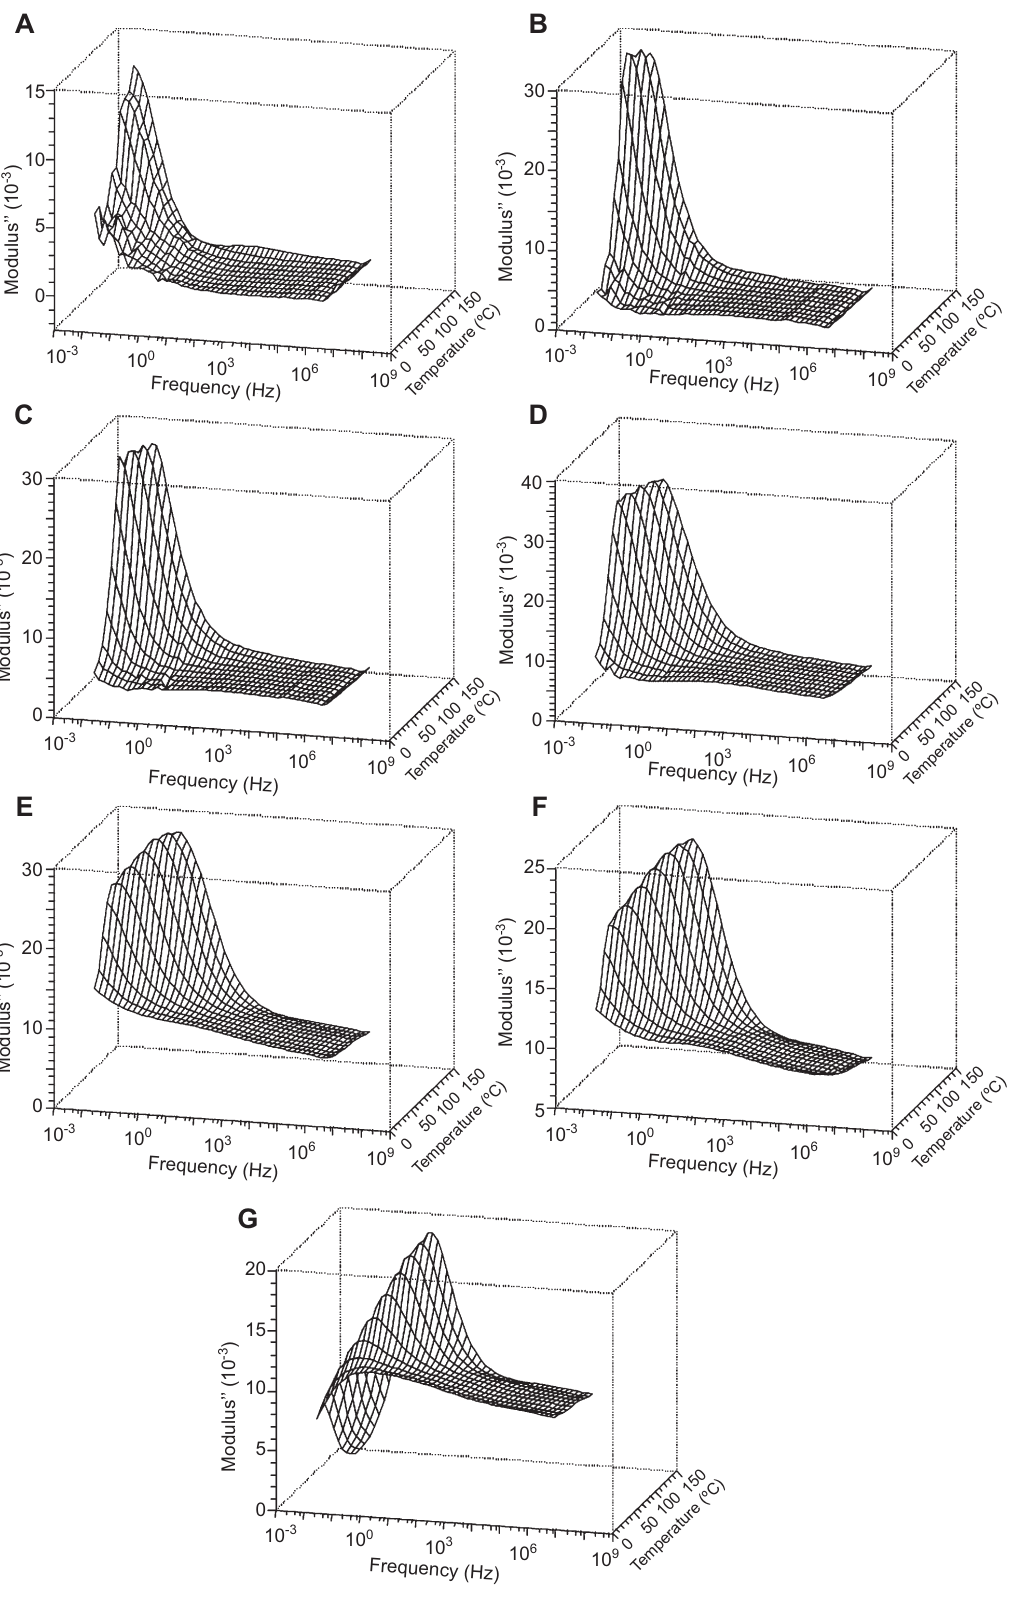
Figure 9 Three-dimensional diagrams of the imaginary component of the electric modulus ( M’’ ) in relation to temperature and frequency: (A) PS, (B) PS/GTR-5%, (C) PS/GTR-10%, (D) PS/GTR-20%, (E) PS/GTR-40%, (F) PS/GTR-50% and (G)